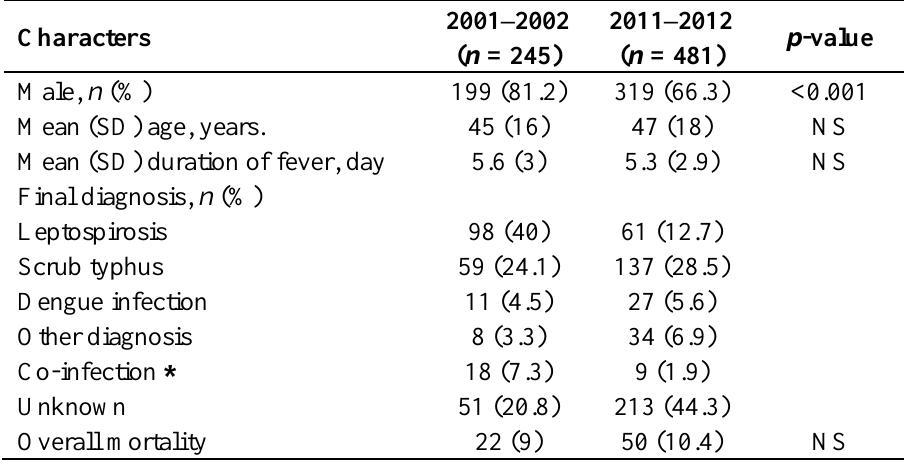
Table 1. Characteristics of AUFI patients in the two study